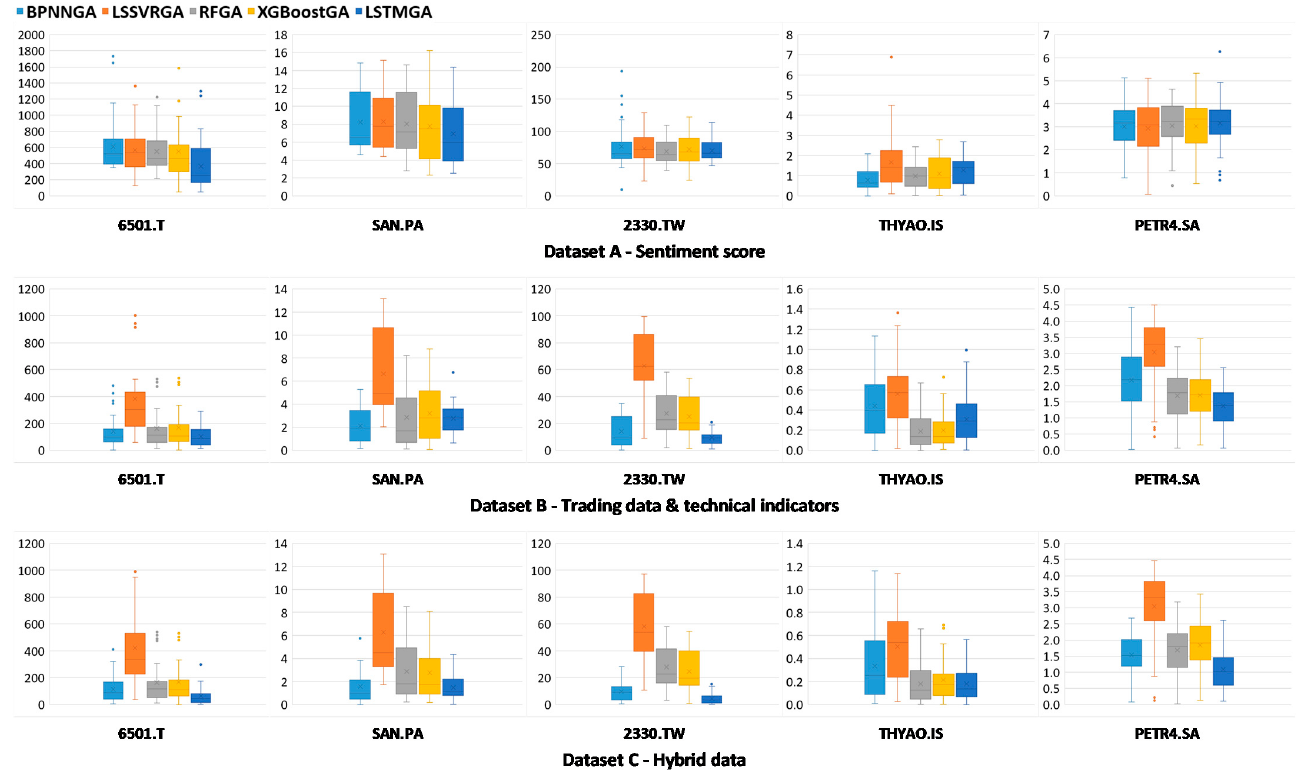
Figure 9. Boxplots in terms of absolute errors for forecasting models with three datasets of corpora- tions’ stocks.